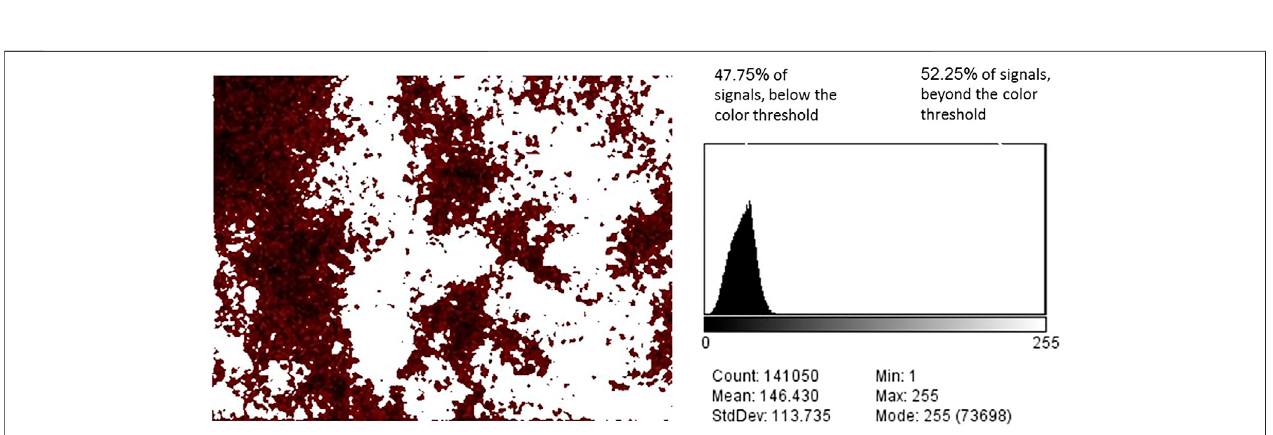
FIGURE 3 | P in SL-Al/O-WTR, after color threshold fi ltration (brightness threshold 102/255). All signals beyond the color threshold turned white (left) . The signals below the color threshold constitute 47.75% of the total signals (right) .